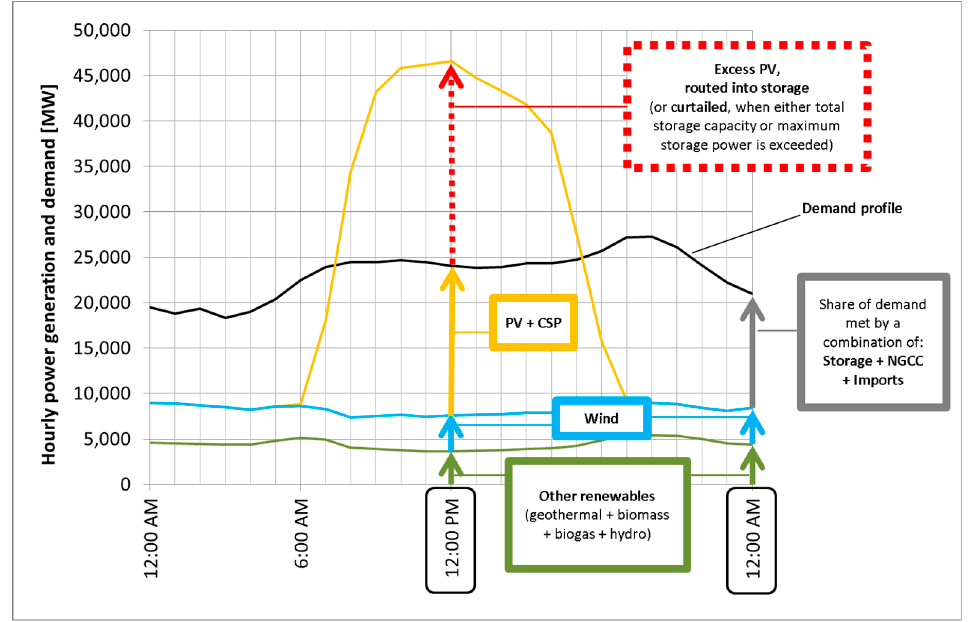
Figure 5. Projected hourly generation and demand profiles for the day of 2 April 2030 in California.